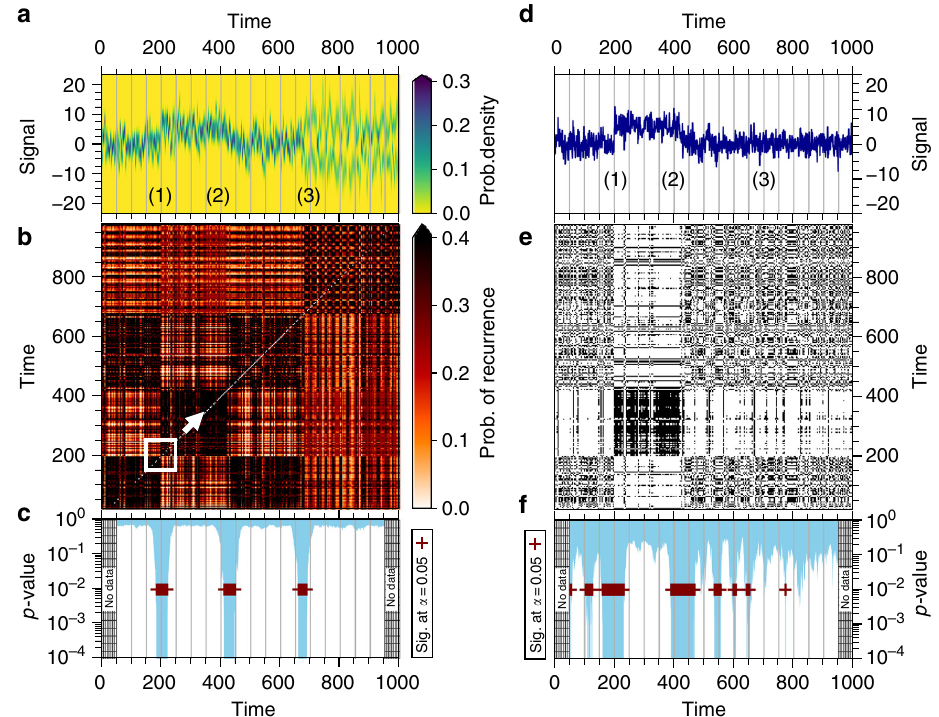
(cid:1) (cid:3) N t ¼ 1 for a synthetically generated